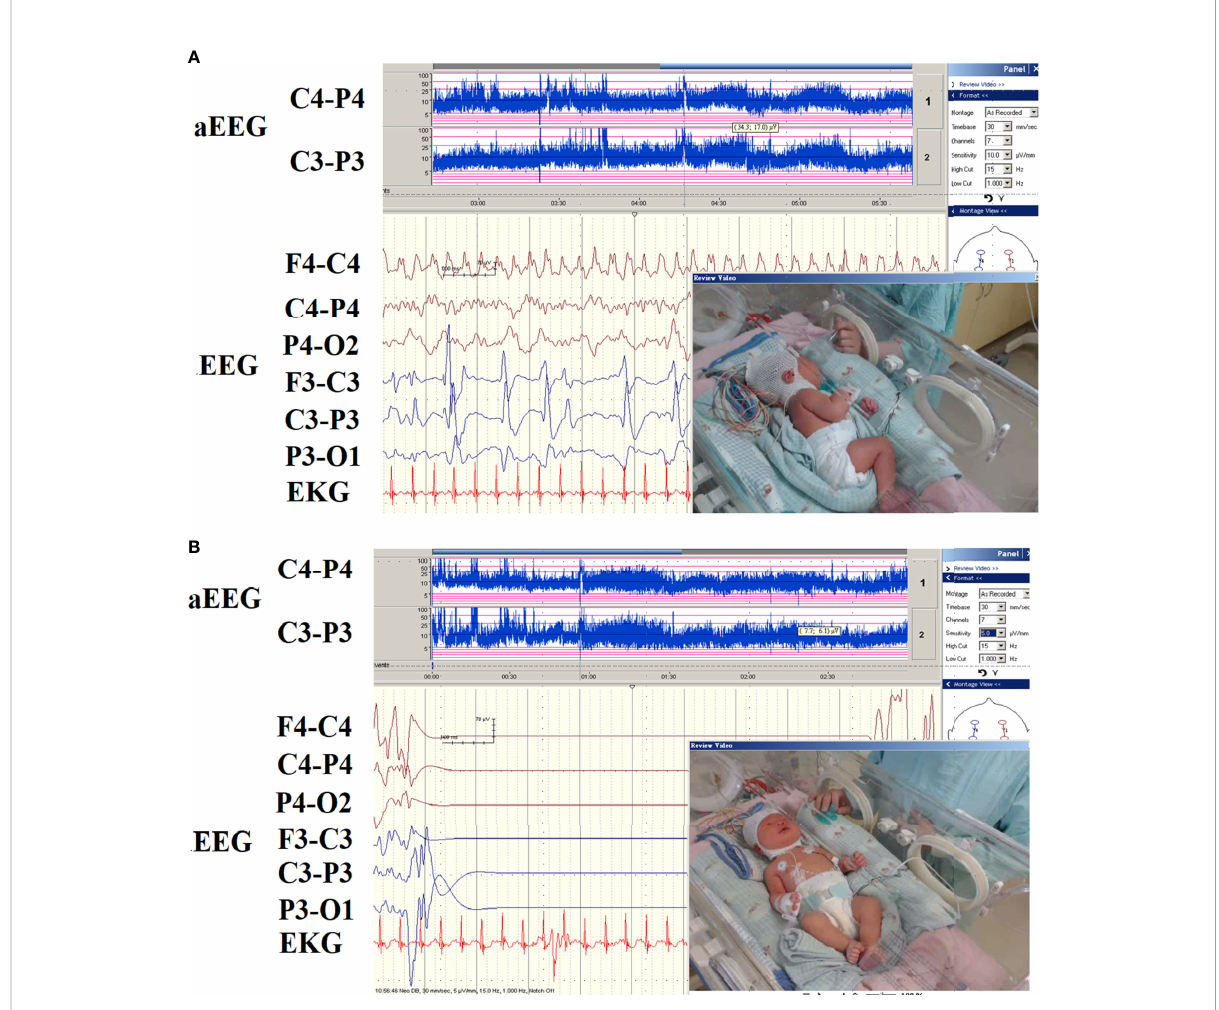
FIGURE 3 The EEG pattern of hypocalcemic seizures on the EEG monitor in patient 16. (A) The EEG monitor exhibited multifocal paroxysmal activity and (B) postictal inhibition of brain activity after seizure. The patients had seizures since day 6 of life due to hypocalcemia and vitamin D de fi